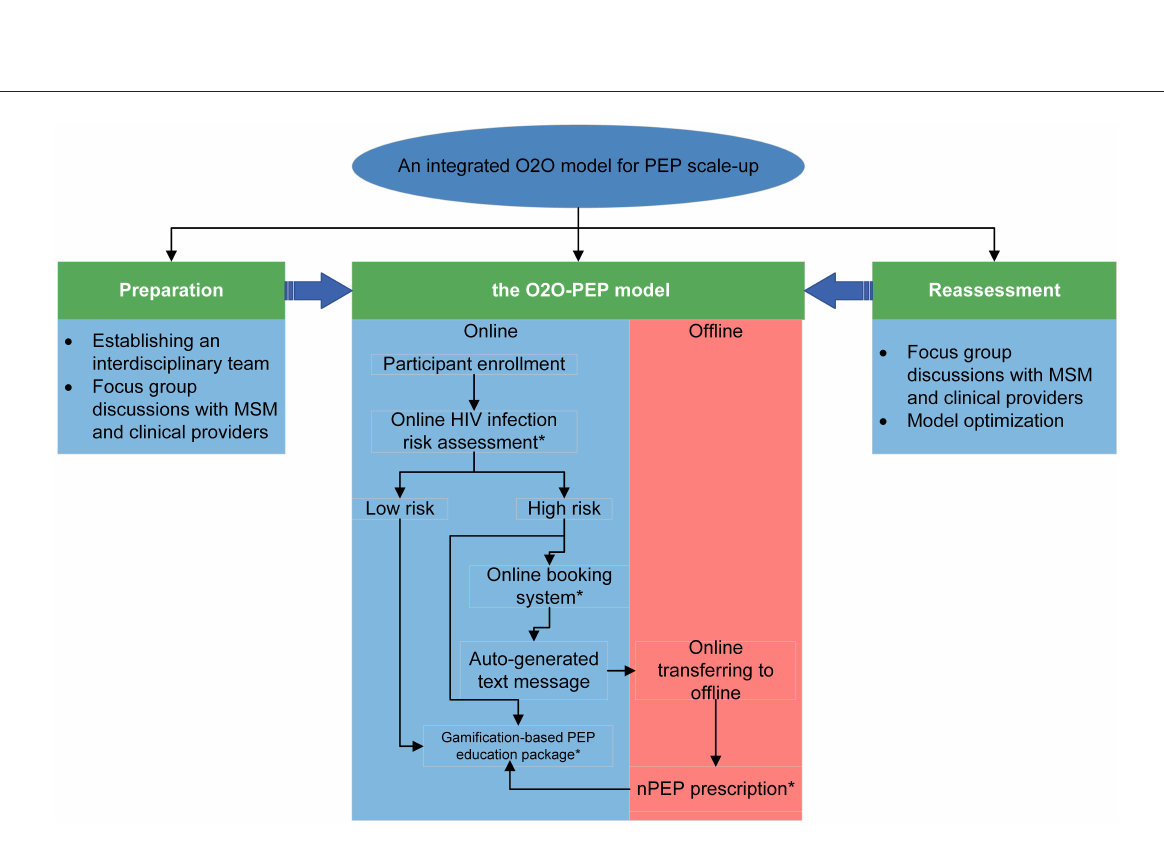
FIGURE2 Overview of O2O-PEP model. O2O, Online to Offline, PEP, Post-Exposure Prophylaxis.